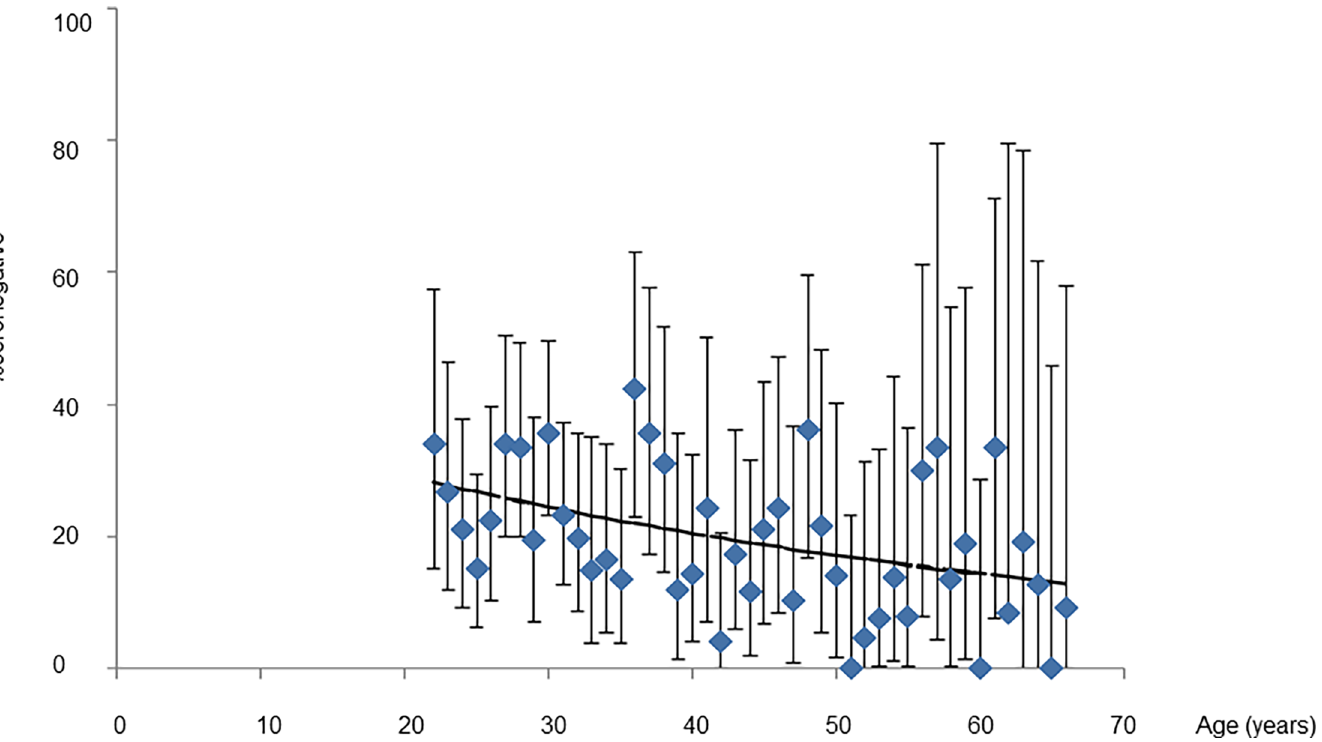
Fig 3. Comparison between the predictions of age-specific percentage seronegative, obtained using the best-fitting catalytic model and the observed data. Bars reflect 95% confidence intervals of the observed data. Lines reflect predictions from the best-fitting model.